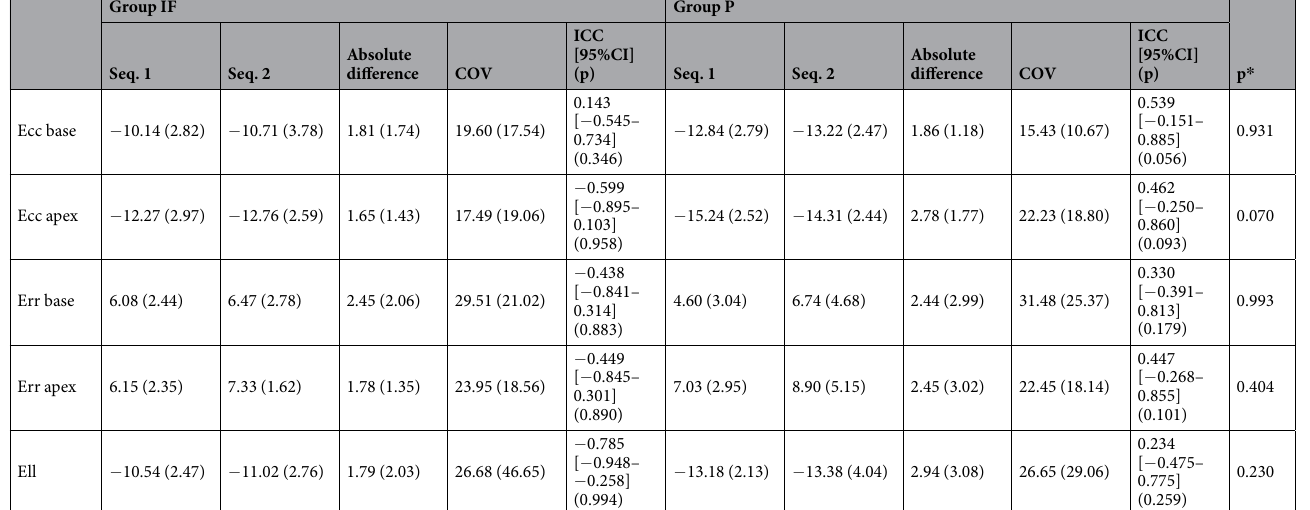
Table 3. Intra-study reproducibility as evaluated by the absolute difference, coefficient of variation (COV) (expressed in %) and interclass correlation (ICC) between results from the first (seq. 1) and second (seq. 2) tagged sequences within the same cardiac magnetic resonance exam during isoflurane (group IF) and pentobarbital (group P) anesthesia. Data are the mean (SD) except for ICC [95% interval confidence] (p). * Comparison of intra-study difference between groups IF and P.